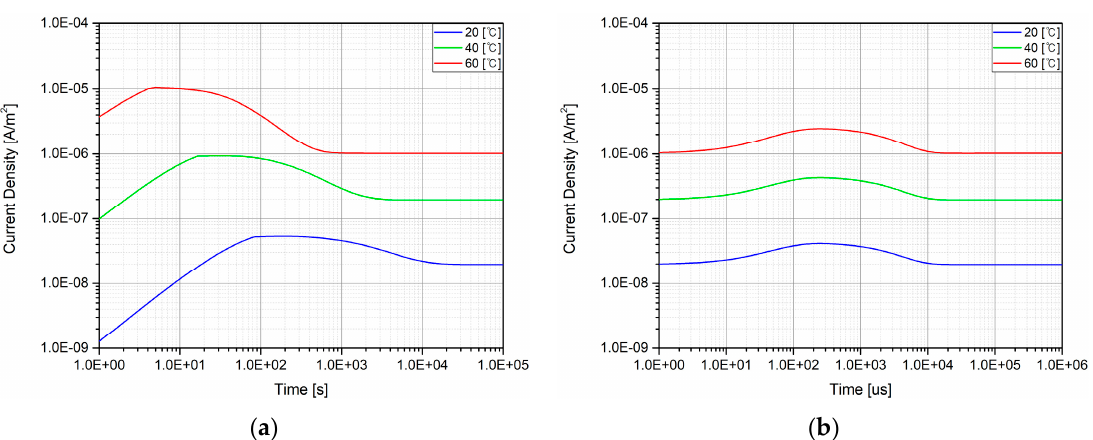
Figure 10. Comparison of current density at different temperature conditions: ( a ) under DC voltage only; ( b ) under switching impulse superimposed on prestressed DC voltage.